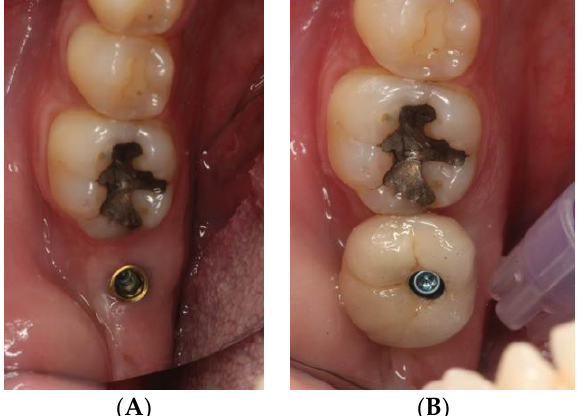
Figure 4. ( A ) implant tissue level PRAMA RF in position 3.7, ( B ) implant tissue level PRAMA RF restored with a screw-retained single crown.